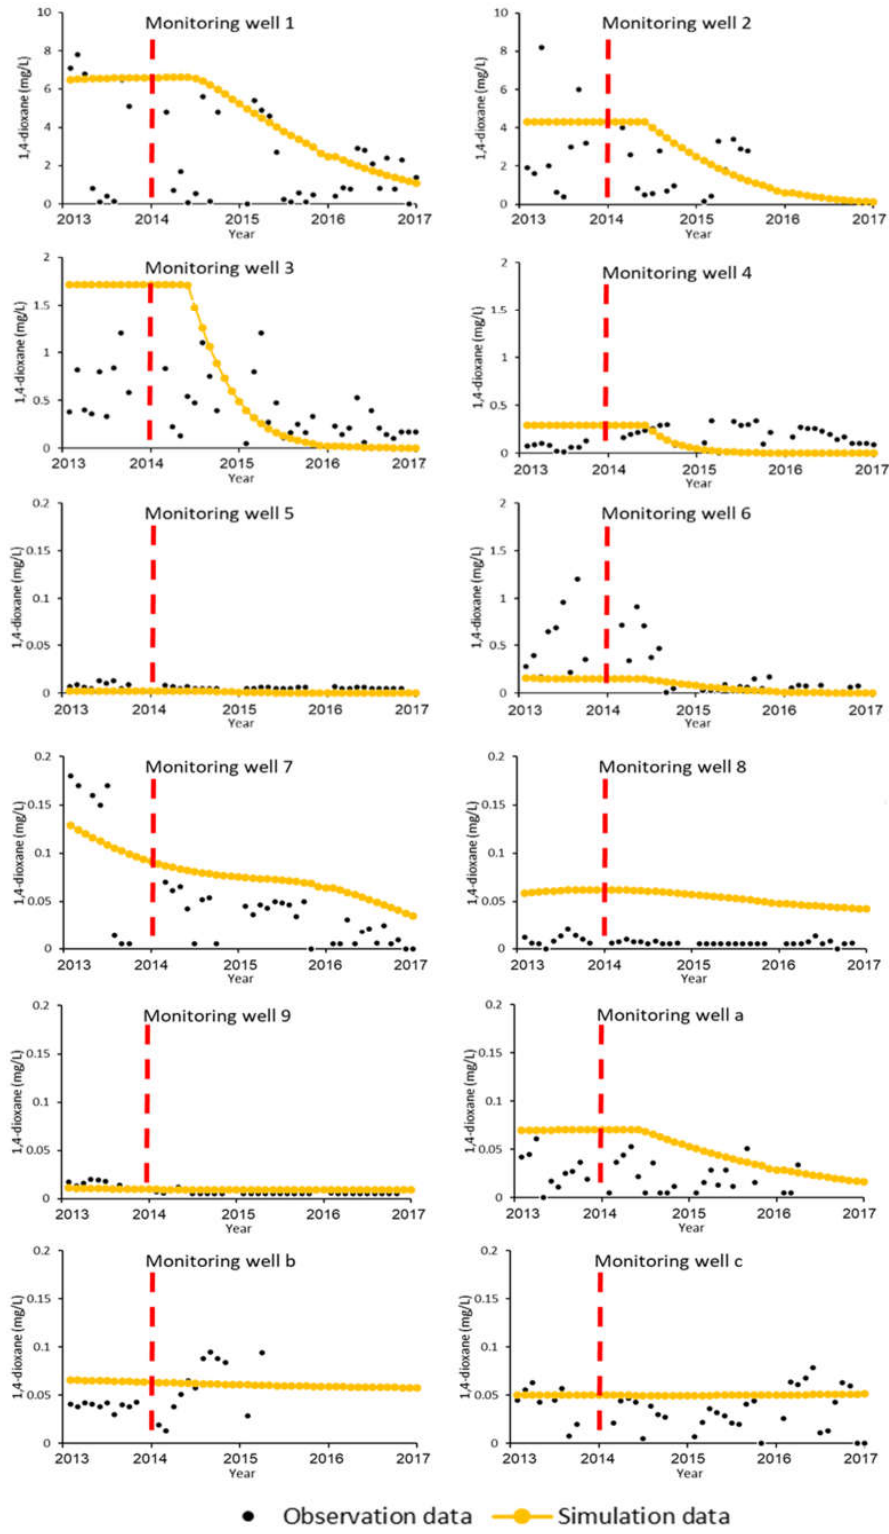
Figure 2. Comparison between the simulation results and observed data of 1,4-dioxane [26]. Red line means the excavation removal completed at the site (2014).